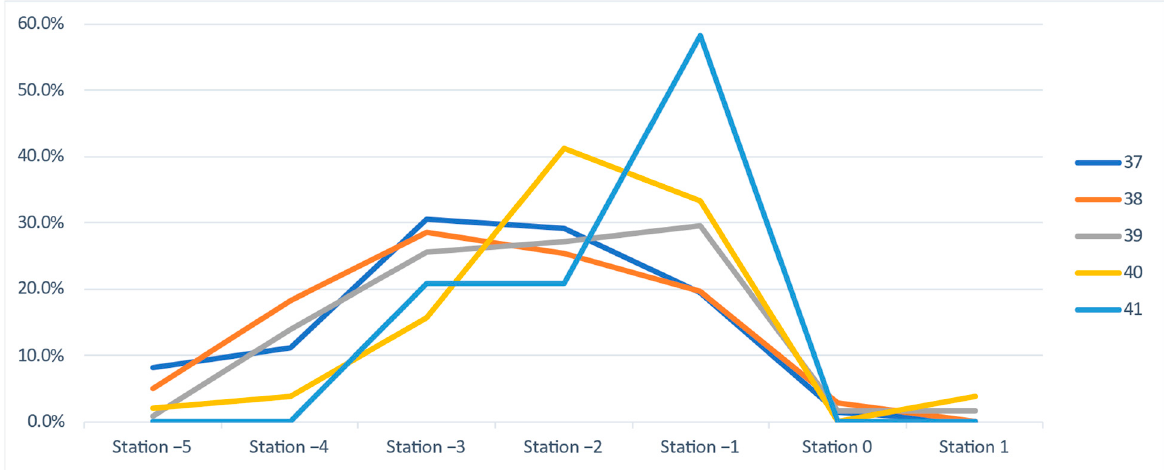
Figure 7. The rates of fetal head stations at each gestational week at term, in the group of vaginal deliveries.